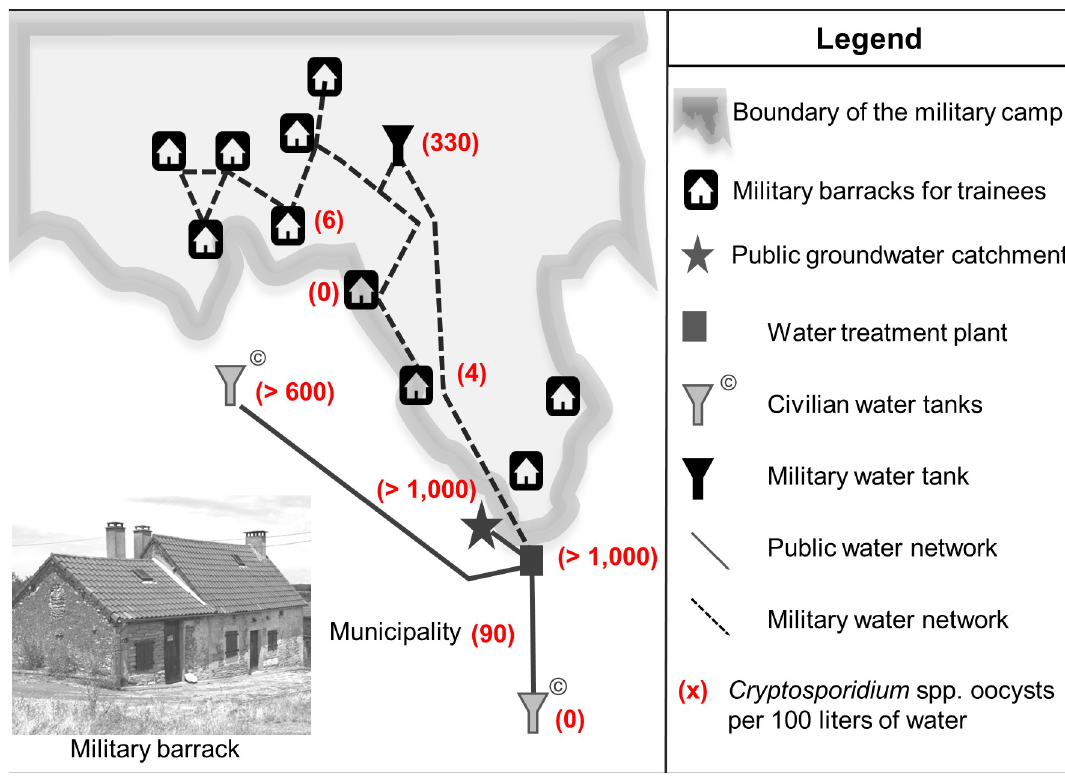
Fig 1. Cryptosporidiosis outbreaks, Cryptosporidium spp. oocysts in several water installations, France, 2017.